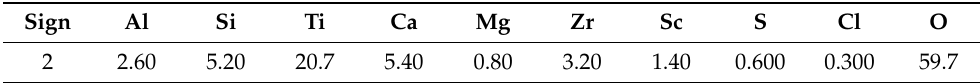
( b ) Figure 13. Effect of S:L ratio on the recovery degree of Al, Ti, Fe, Sc at 150 °C and 20% HCl ( a ) and effect of HCl concentration on recovery degree of Al, Ti, Fe, Sc at 150 °C and S:L = 1:11 ( b ). 4. Discussion The HPAL of the tailings using the diluted hydrochloric acid allows the selective separation of REEs and Al from Ti and SiO 2 with high effectivity. The obtained residue can contain more than 20% TiO 2 and over 50% SiO 2 (Table 3) which indicates that it is a valuable raw material for Ti extraction. To extract Ti, various leaching treatments have been suggested, such as using the mixture of hydrogen peroxide and sulfuric acid with a suppression of Si dissolution [71], as well as using alkaline solutions [72], phosphoric acid [47], etc. However, the most promising way for Ti extraction from the residue is the leach- ing by concentrated hydrochloric acid with its dissolution and subsequent precipitation of TiO 2 [73]. The obtained amorphous SiO 2 can be used for the production of white carbon black [74]. REEs can be relatively simply recovered from the leached solutions by well-known methods, e.g., solvent extraction, ion-exchange sorption, selective precipitation, etc. [75]. The remaining aluminum chloride solution can be used as a coagulant for water treatment